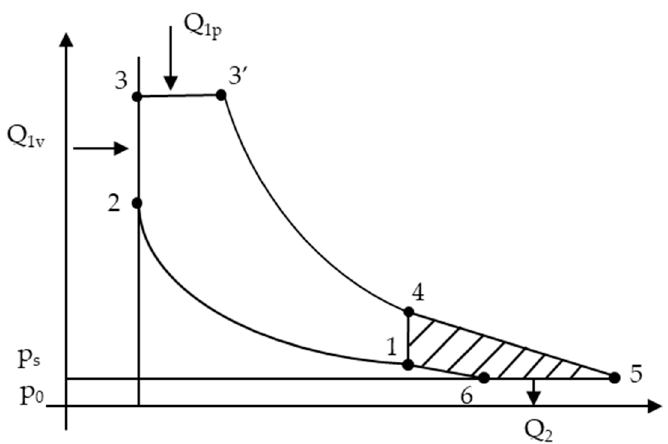
Figure 1. Mixed turbocharged cycle [14].